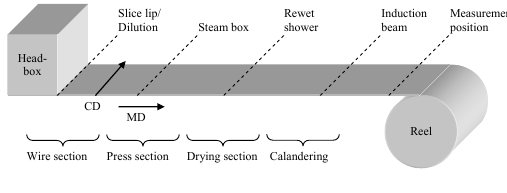
Figure 1: Paper manufacturing process. There are significant interactions between different properties and actuators in the paper machine (Back- strom and He, 2004). Hence actuations performed to one property may have unfavorable effects to another property. For instance, the slice lip actuators primar- ily used for controlling the basis weight variations will also affect on moisture and caliper, which are controlled with downstream actuators. Further, there might